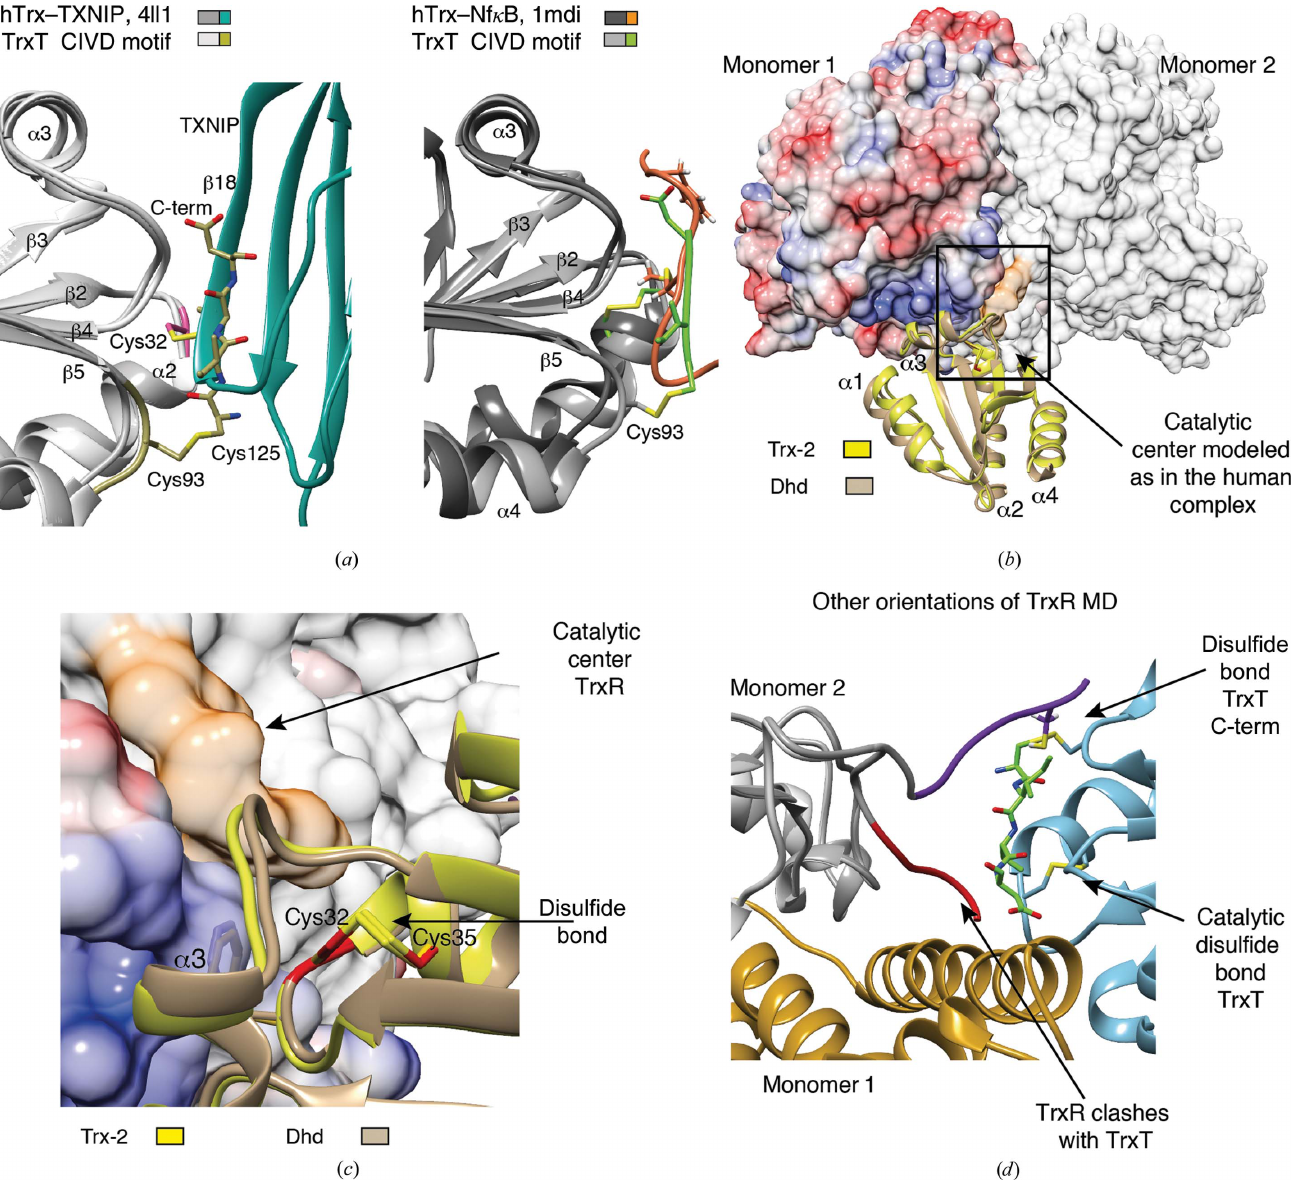
Figure 4 Comparison with other Trx protein complexes. The C-terminal fragment modulates the stability and redox activity of TrxT. ( a ) Comparison of the overall structure of TrxTwith those of human Trx in complex with TXNIP (left; PDB entry 4ll1) and human Trx in complex with NF (cid:8) B (right; PDB entry 1mdi), using human Trx for the fitting. The C-terminal CIVD motif of TrxT (shown in chartreuse) occupies the same position as the Trx partners in the human Trx complex structures. Full molecules are shown in Supplementary Figs. S4( a ) and S4( b ). ( b ) Model of Trx-2 and Dhd structures docked to Dm TrxR as observed in the human TrxR–Trx complex. The catalytic center of TrxR is able to access the Cys32–Cys35 bond, shown in red, in both Drosophila thioredoxins (PDB entry 3qfa). ( c ) Close-up view of the interaction between the catalytic center of the reductase (colored orange and indicated with an arrow) and the oxidized forms of Trx-2 (yellow) and Dhd (tan) rotated 90 (cid:4) with respect to the view shown in ( b ). The catalytic Trx and Dhd cysteines are shown in red. The (cid:3) 3 helix of Dm Trx and Dhd that participates in direct contacts with the reductase is labeled. ( d ) Close-up view of the model of TrxT bound to Dm TrxR as depicted in Fig. 4( b ). The catalytic center of TrxR as determined in the human complex cannot access the Cys32–Cys35 bond in TrxT due to the presence of the C-terminal motif attached to Cys93 in the core domain (both sites are indicated with arrows). The orientation shown in purple will allow the reduction of Cys93–Cys125 of the tail. Once this step is achieved, a second reaction can occur to reduce the Cys32–Cys35